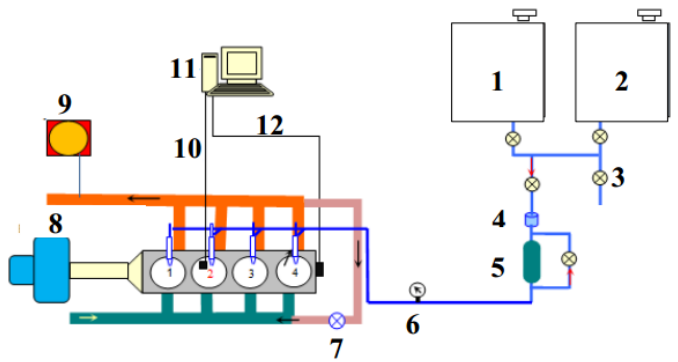
Figure 1. Schematic diagram of experimental engine setup: (1) diesel fuel tank;